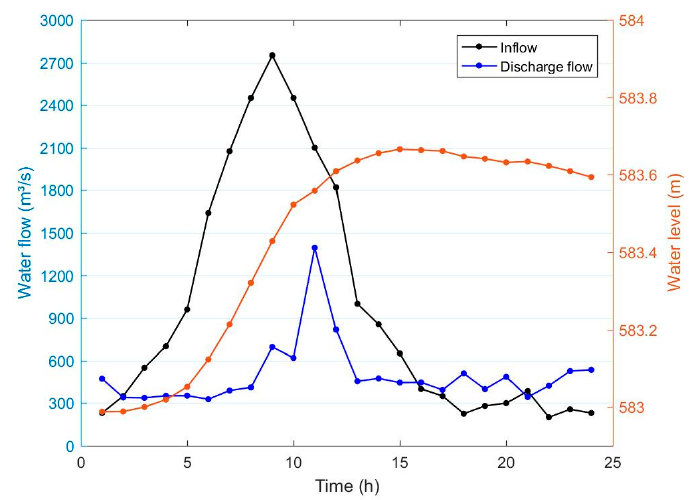
Figure 17. Water storage change process without hedging